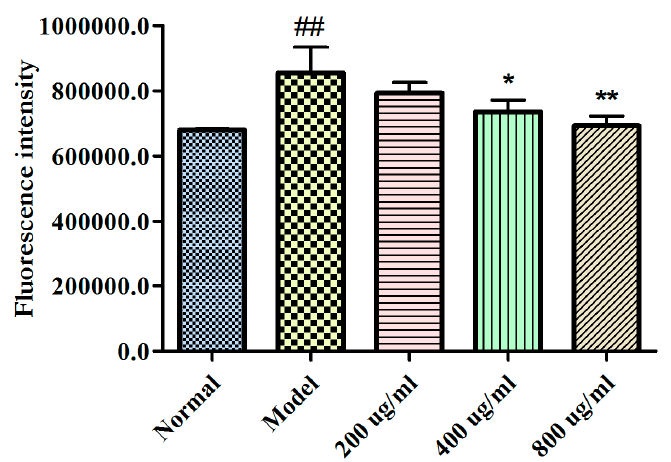
Figure 3. Effects of BBPs on Ca 2+ levels of NGF-induced PC12 cells injured by Glu. The intracellular Ca 2+ level by the flow cytometry (FCM) assay. PC12 cells (induced by 50 ng/mL NGF for 48 h) were treated with BBPs at concentrations of 200, 400 and 800 μ g/mL for 24 h, subsequently subjected to Glu at the concentration of 20 mmol/L for a further 24 h. Normal group: NGF-induced cells without BBPs and Glu; Model group: NGF-induced cells without BBPs, but with 20 mmol/L Glu; BBPs: protein extracts in Bombyx batryticatus. The values represent mean ± SD ( n = 6). ## P < 0.01, vs. normal group; * P < 0.05 and ** P < 0.01, vs. model group.